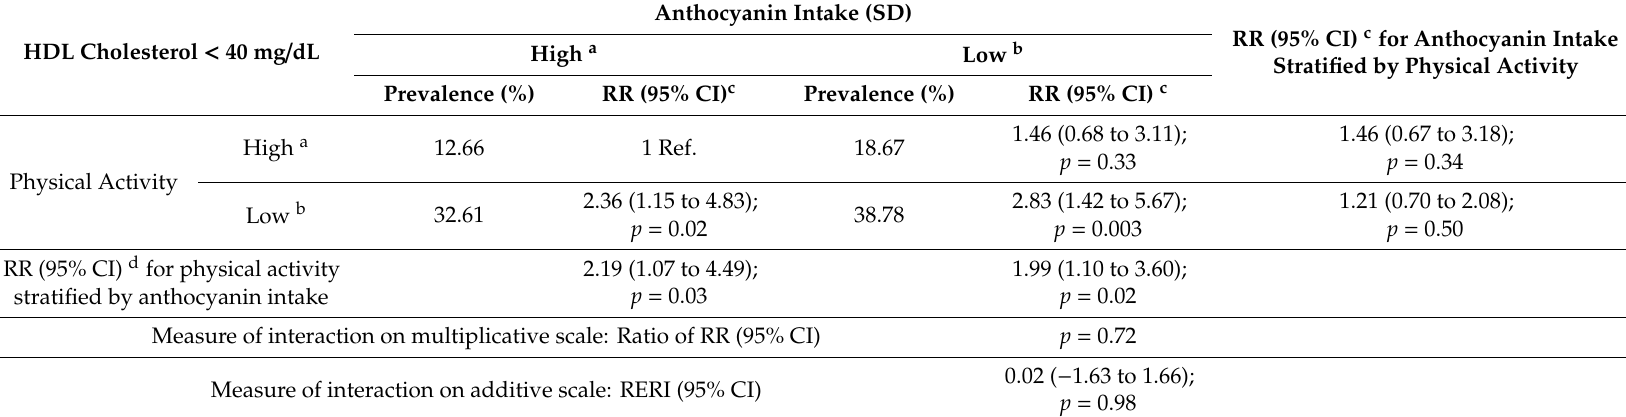
Table 5. Prevalence, joint e ff ect relative risk (RR), stratification, and multiplicative and additive interactions of anthocyanin intake and physical activity on HDL cholesterol < 40 mg /